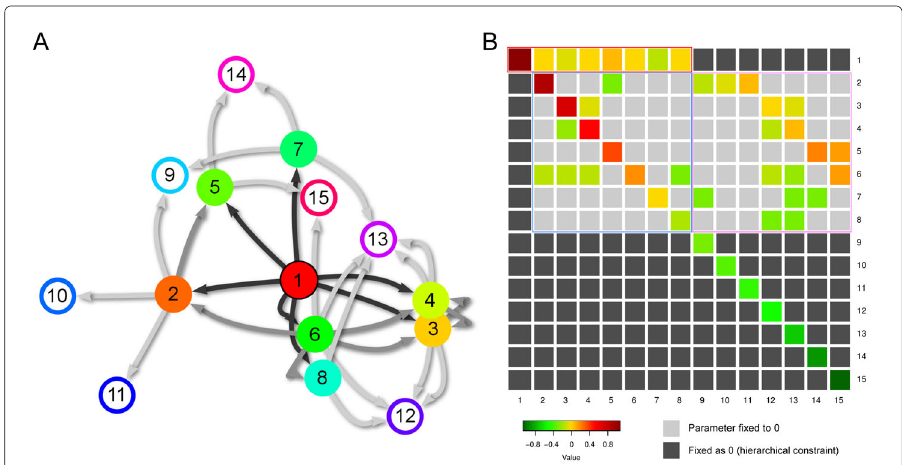
Fig. 2 Configuration of the Simulated Hierarchically Differentiation Process. a Network configuration of the SHDP.Theassumedstructuremimicsapotentialmodelforhumanhematopoiesisaccordingtobothliterature and experimental data. Network layout has been generated with a force directed layout. b Parameters heatmap. Main diagonal elements correspond to netduplicationrate . Off-diagonal elements correspond to differentiation rates (row → column). Light-Grey entries are differentiations rates fixed to 0 but in the set of the potentially present differentiation paths (67). Dark-Grey entries are excluded from the inferential procedure due to violation of hierarchical constraints (112). The colored boxes correspond to: red, top to middle layer connections; blue, middle layer inter-connections; pink, middle to bottom layer